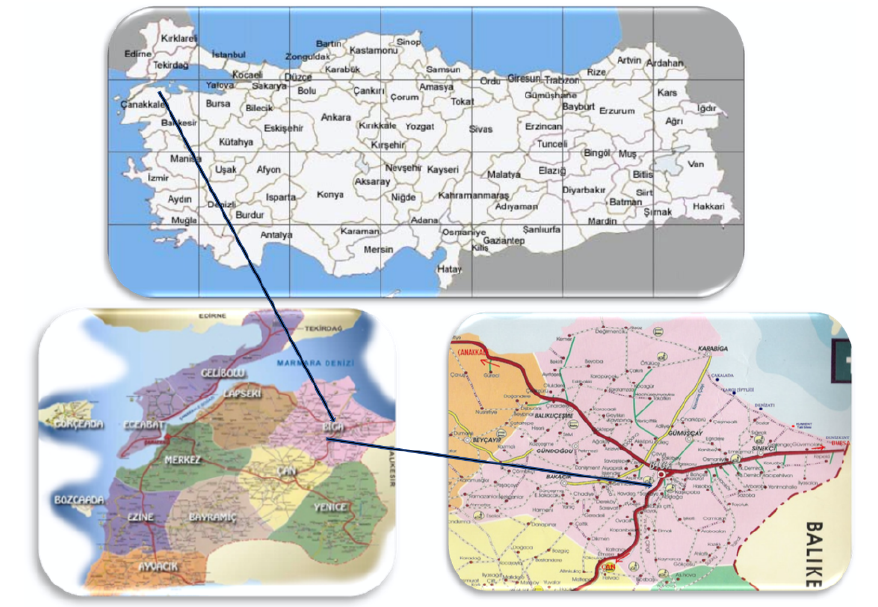
Figure 1 Map of the study area (Biga/Çanakkale).